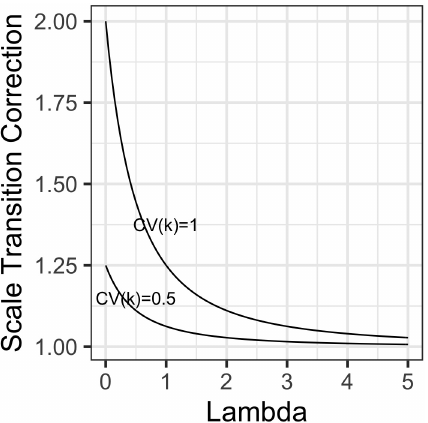
Figure 4. Scale transition factor for variations in the substrate affin- ity (“ k h ”) parameter in Michaelis–Menten kinetics as a function of dimensionless λ (the ratio of mean-field microbial biomass over mean-field k h ), for two scenarios of variability in affinity, one where coefficient of variation = 1 (top curve) and the other where coeffi- cient of variation = 0.5 (bottom